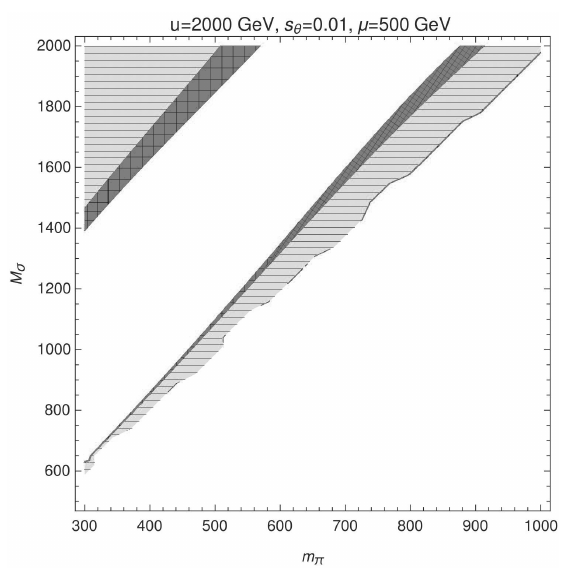
Figure 3. Phase diagram in terms of M ˜ σ and m ˜ π , the same u but the mixing is